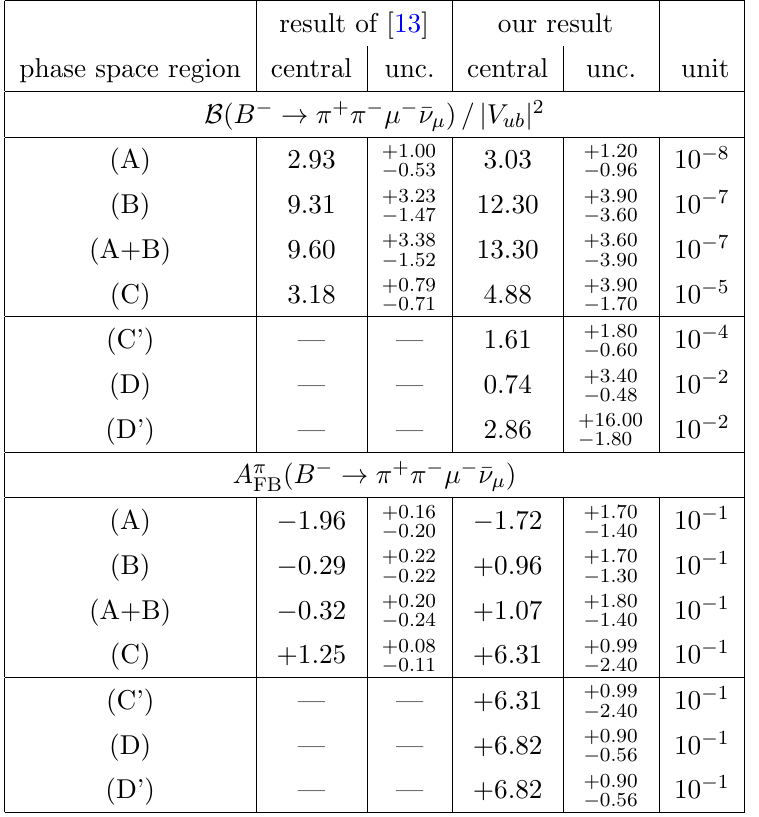
2 ) and the pionic (in units of V ub B j j